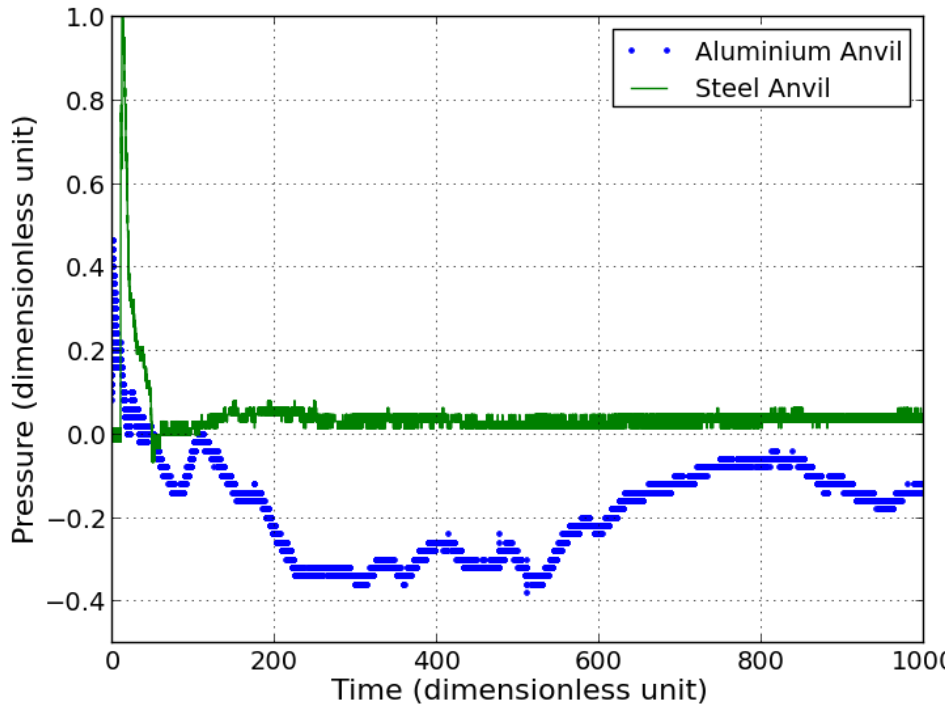
Figure 9. Signals obtained with a PVDF gauge (dimensionless units) on aluminium anvil and on steel anvil using explosive at 100 charge